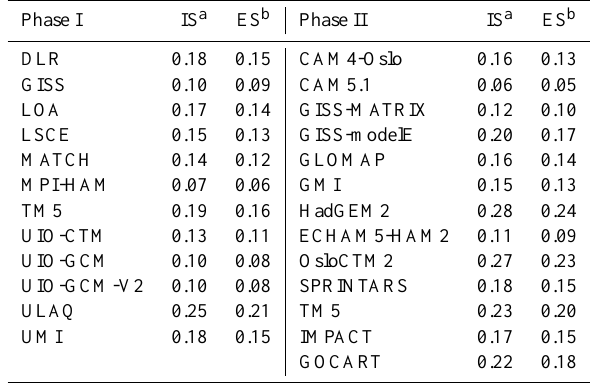
Fig. 9. Seasonal cycle of black carbon deposition fluxes averaged over the Arctic (60 ◦ N to 90 ◦ N) for phase I (left panel) and phase II (right panel) models. (Note the scale on ordinate is different for the two plots.) Table 4. Arctic BC-in-snow radiative effects, averaged from 60 ◦ N to 90 ◦ N (Wm − 2